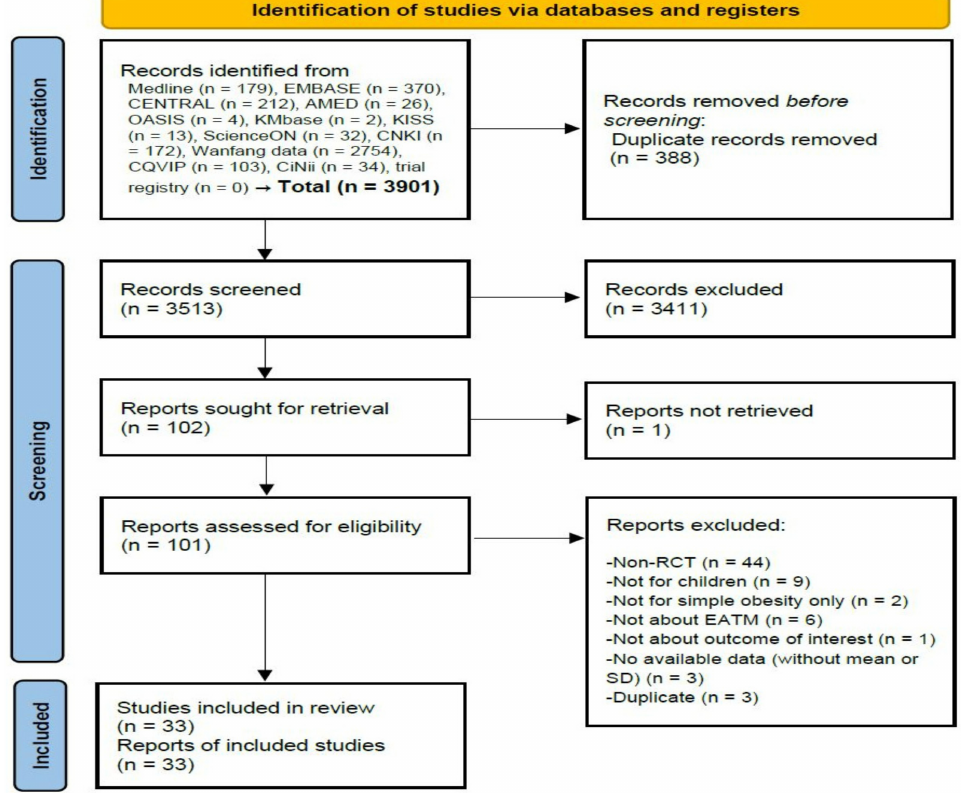
Figure 1. A PRISMA flow diagram of the literature screening and selection processes. AMED = Allied and Complementary Medicine Database, CENTRAL = Cochrane Central Register of Controlled Tri- als, CNKI = China National Knowledge Infrastructure, EATM = East Asian traditional medicine, KISS = Koreanstudies Information Service System, KMbase = Korean Medical Database, OASIS = Oriental Medicine Advanced Searching Integrated System, RCT = randomized controlled clinical trial, and SD = standard